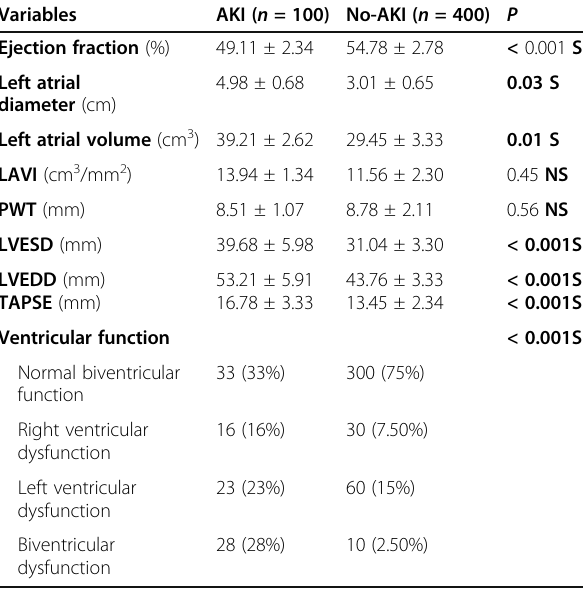
Table 4 Echocardiography in studied patients based